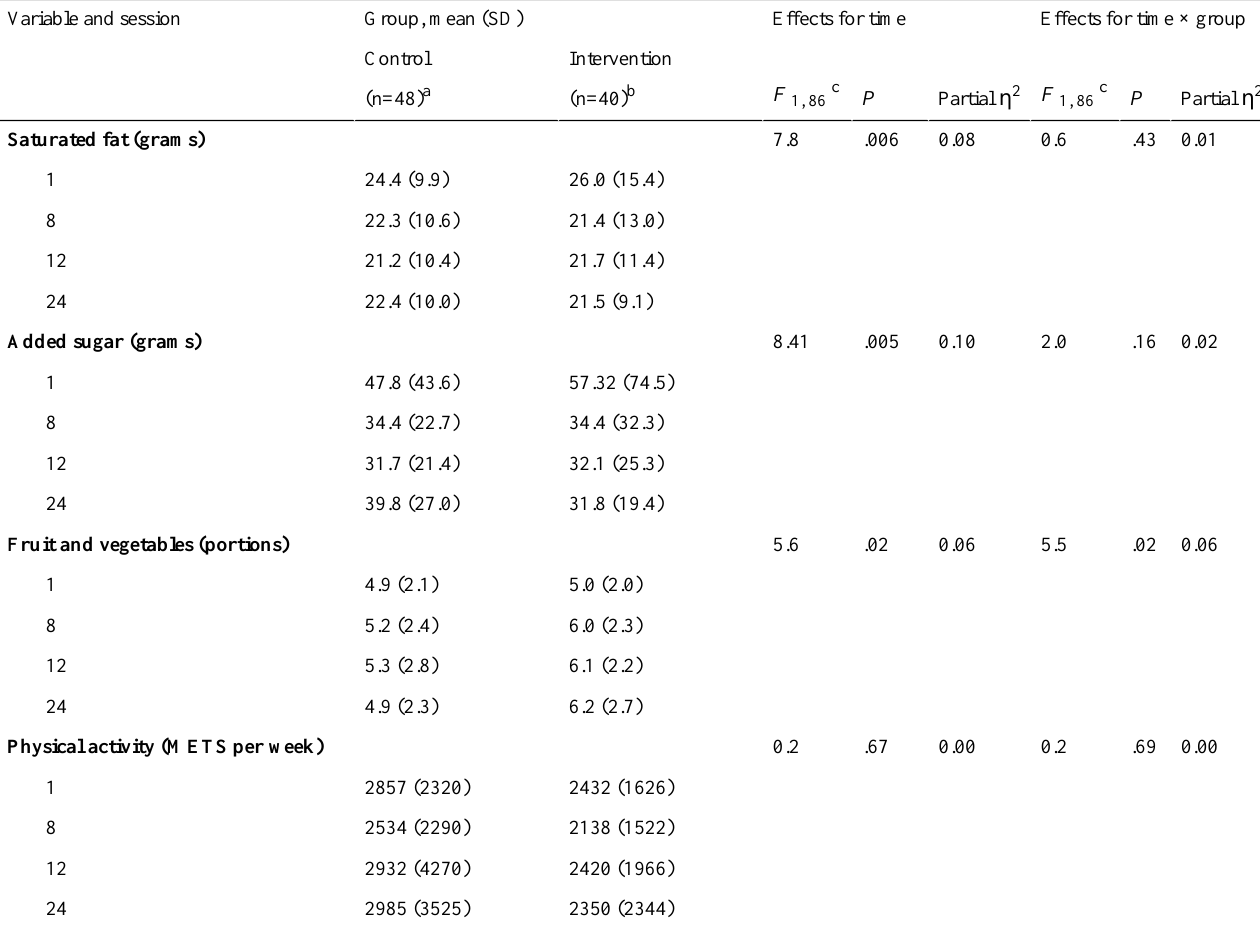
Table 4. Means (SDs) and results from ANOVA models for secondary outcomes assessed online at sessions 1, 8, 12, and 24 in the intervention and control groups, for the per protocol analyses.